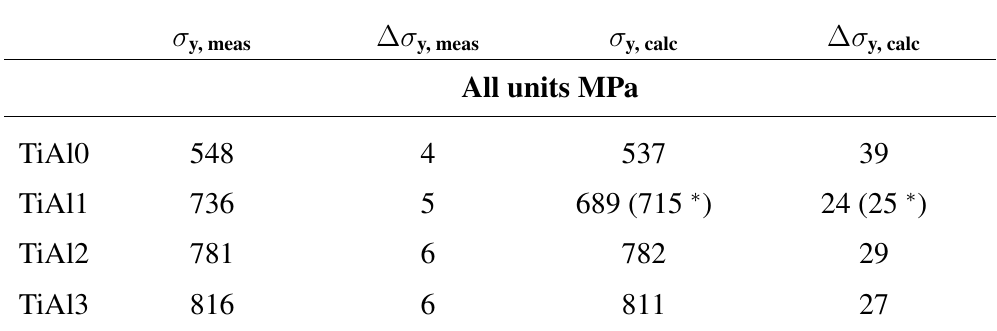
Table 3. Measured composite yield stresses σ compared with the calculated values based on nanoindentation hardness, σ and ∆ σ are obtained by a detailed calculation of errors given in the y,calc